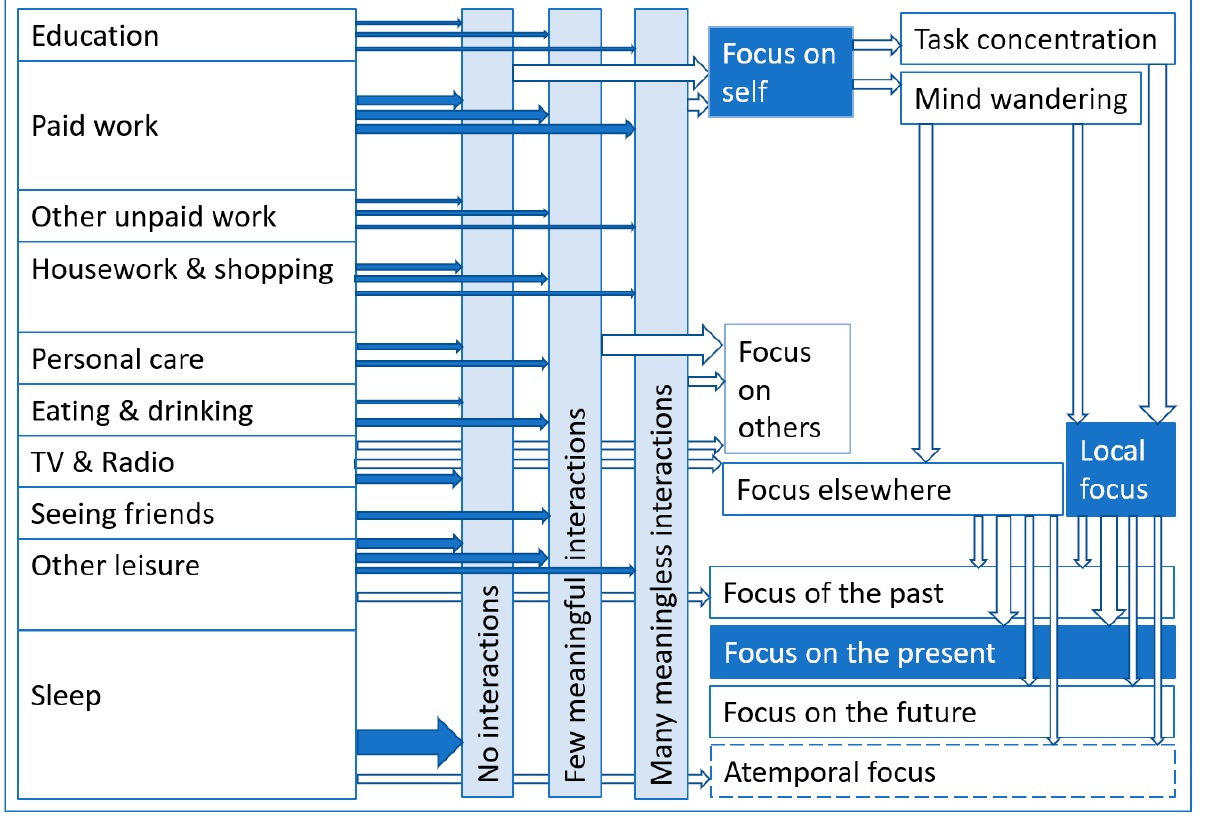
Figure 4. Summary of how common daily activities fit onto the temporal, spatial, and social focus dimensions. While the activities in the left ‐ hand column are roughly weighted according to the time allocated daily by an average person (Ortiz ‐ Ospina et al. 2020), data that are needed to weigh the other blocks are lacking.